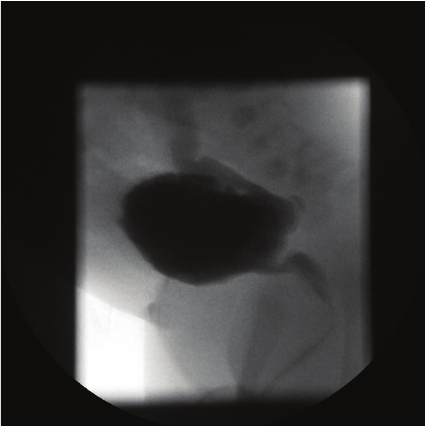
Figure 2: Voiding cystourethrogram confirming the posterior urethral